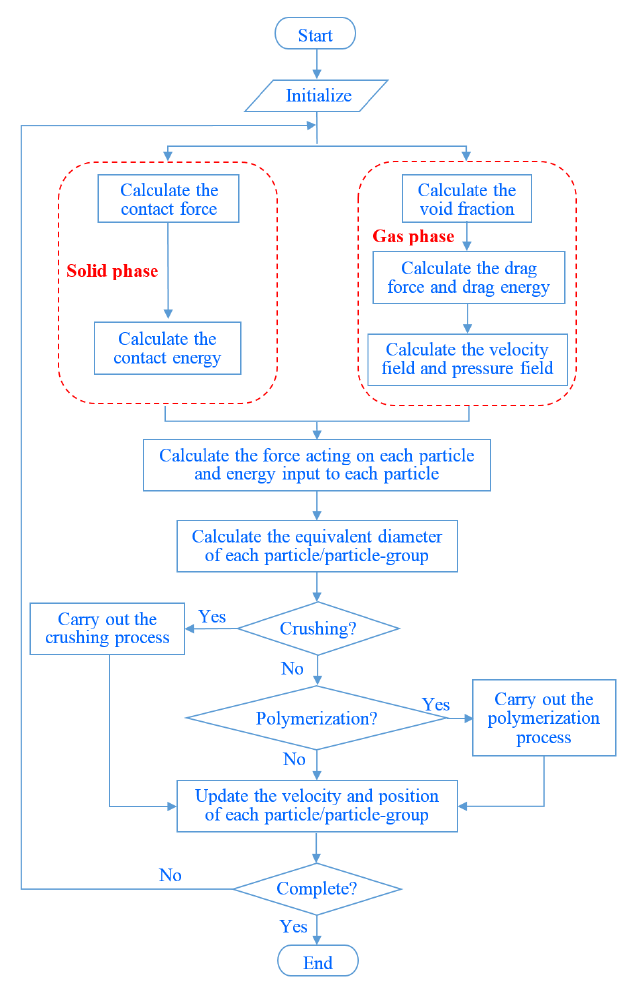
Figure 4. Flow chart for the coarse grain DEM-CFD method with considering the particle-group crushing and polymerization. crushing and